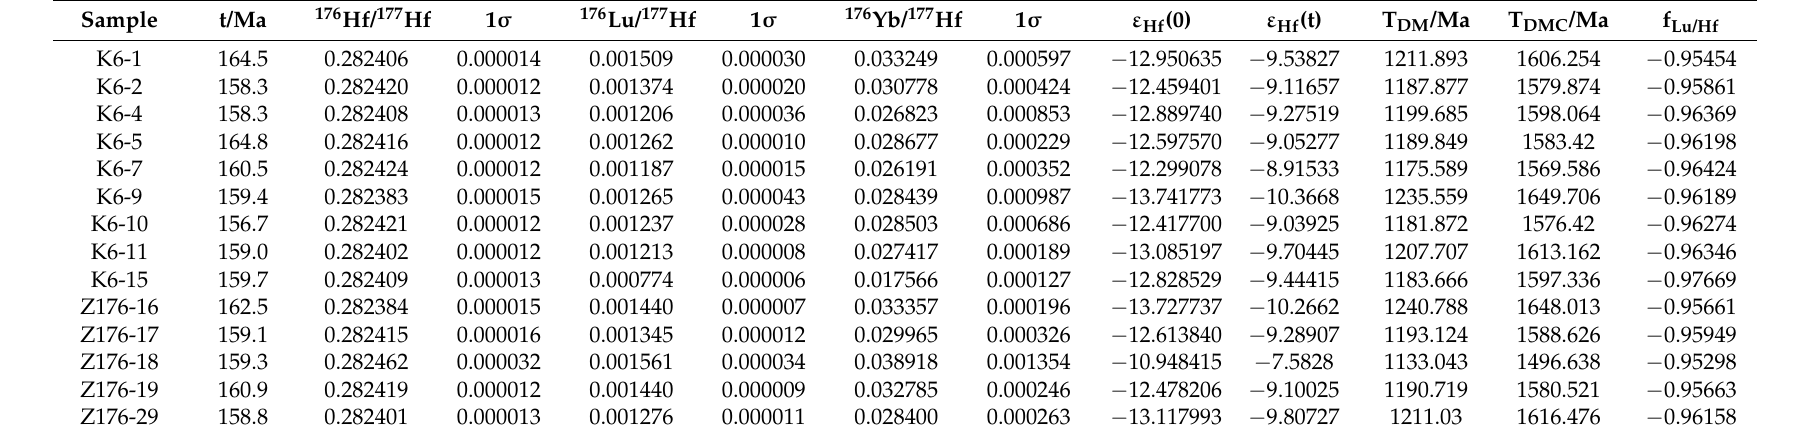
Table 7. The Hf isotopes of the Xiajinbao